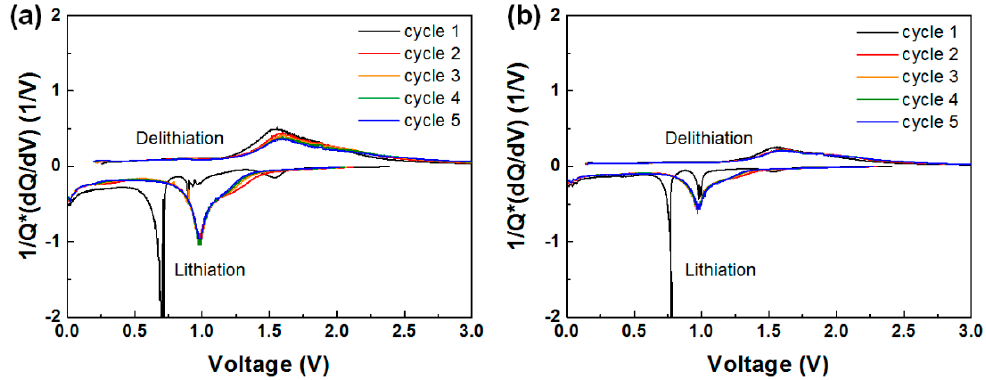
Figure 7. Normalized differential capacity plots of ( a ) ZFO–G and ( b ) ZFO–G–GL for the first five cycles at a current density of 1 A g − 1 .